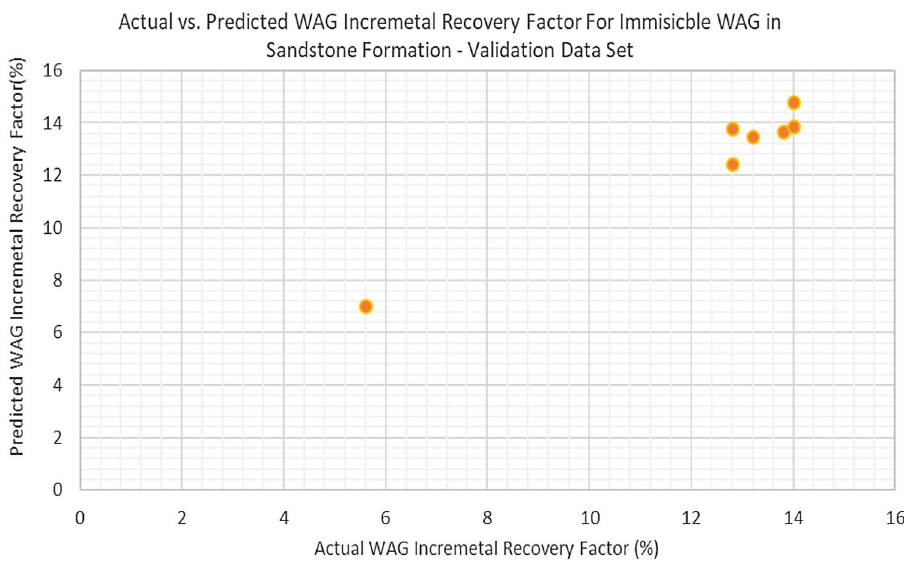
Fig. 19 GMDH WAG incre- mental recovery factor predic- tion model validation results for miscible WAG in carbonate